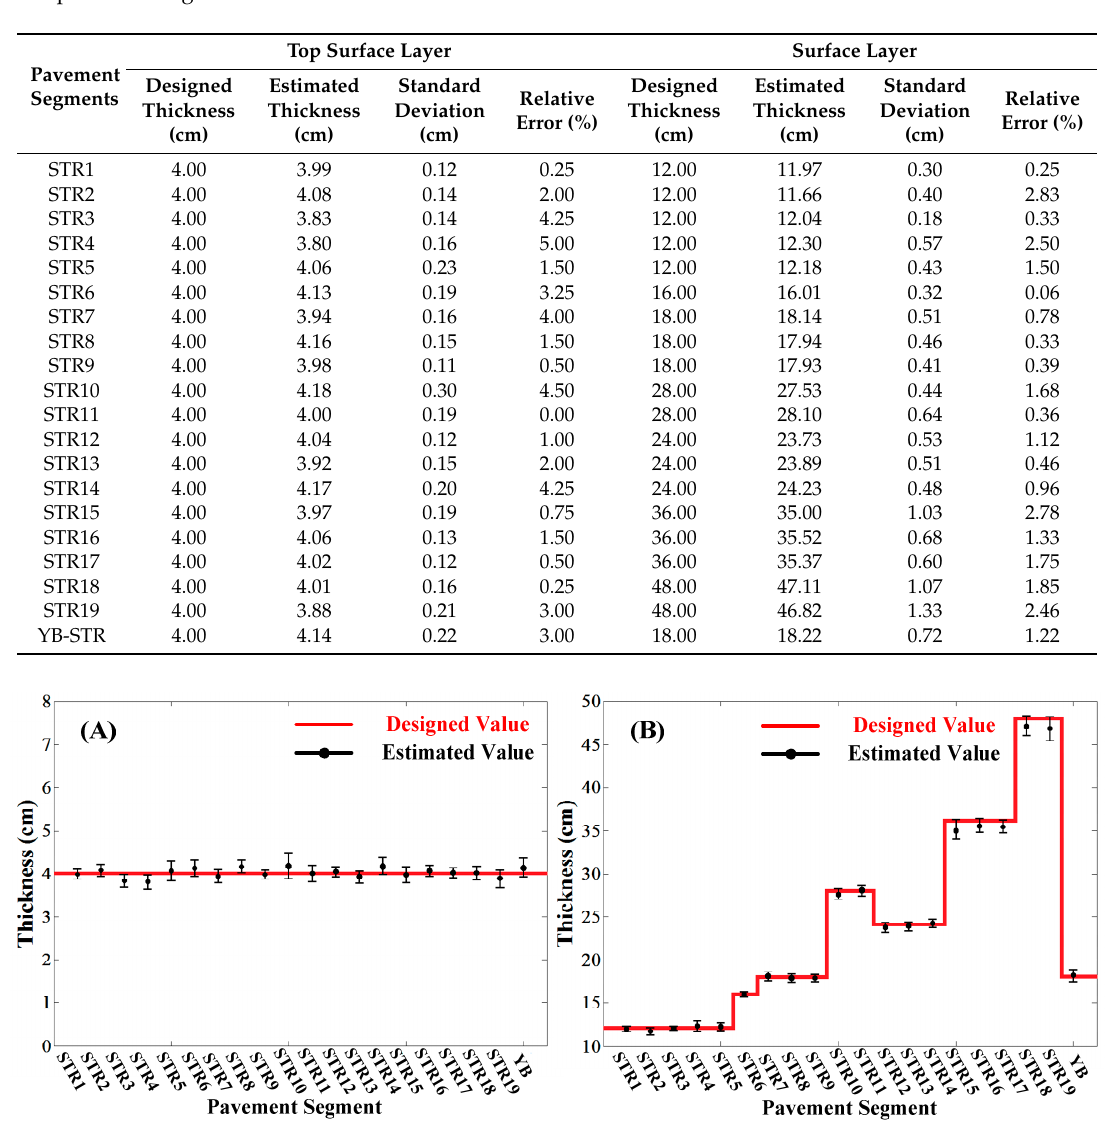
Table 2. The estimated thicknesses and relative errors of the top surface layer and surface layer of each pavement segment.